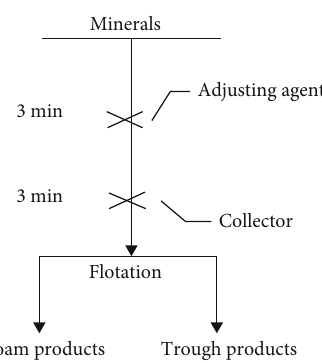
Figure 3: Single-mineral fl otation test fl ow